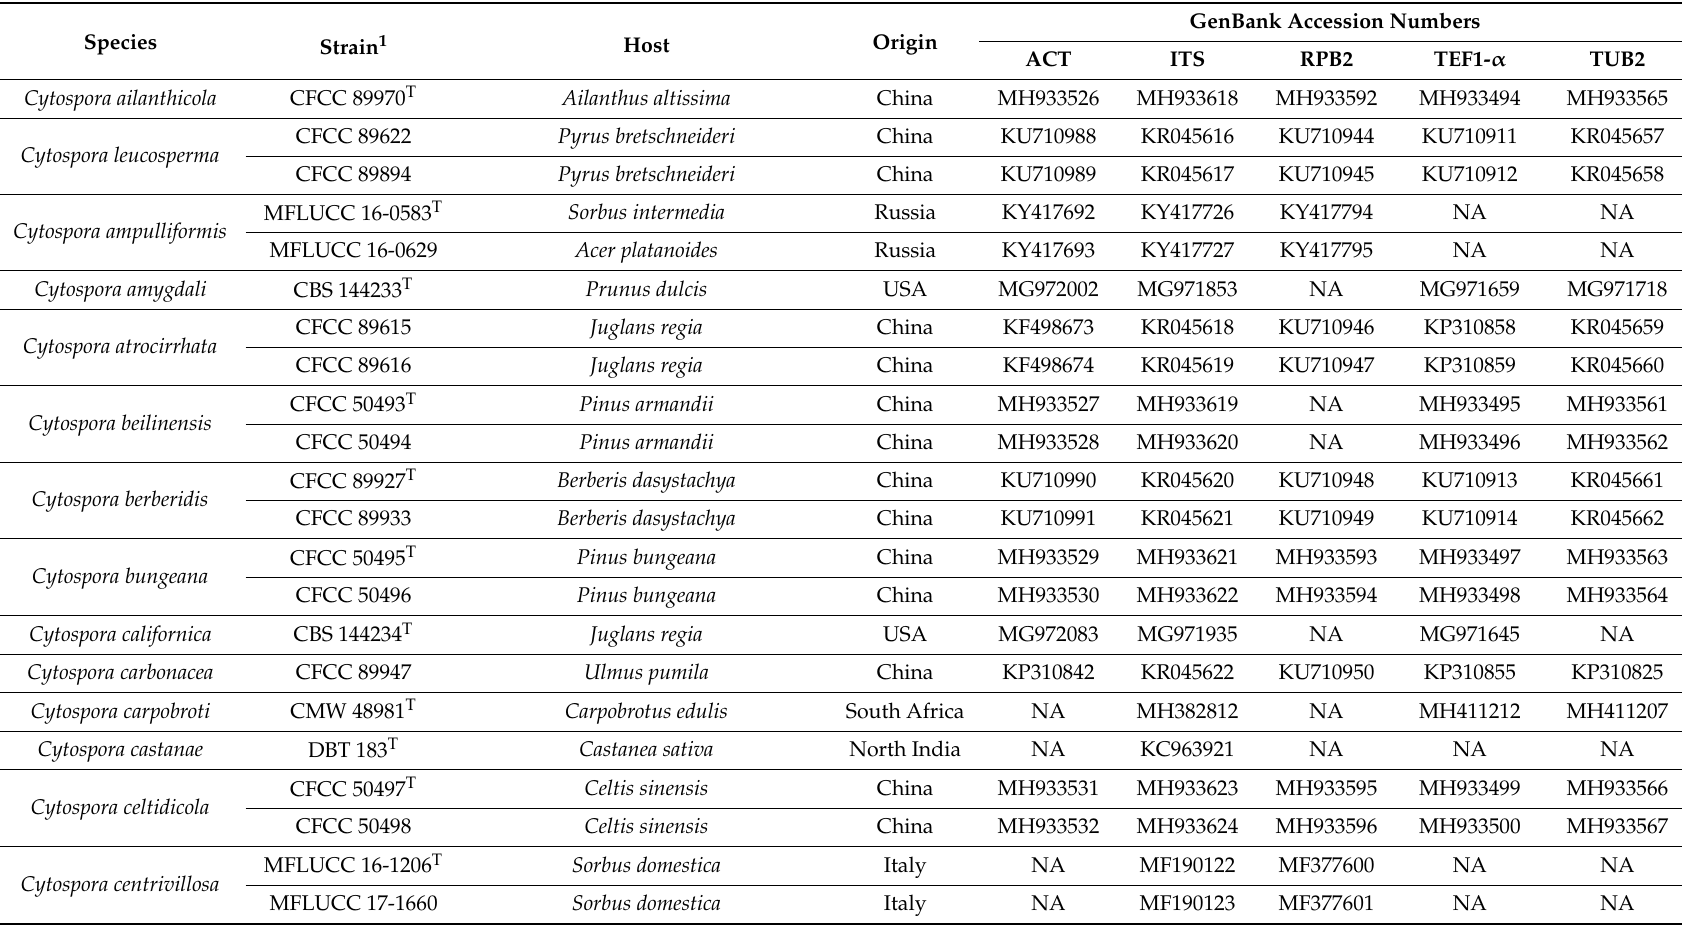
Table 1. Strains and GenBank accession numbers of Cytospora species used in the phylogenetic analyses in this